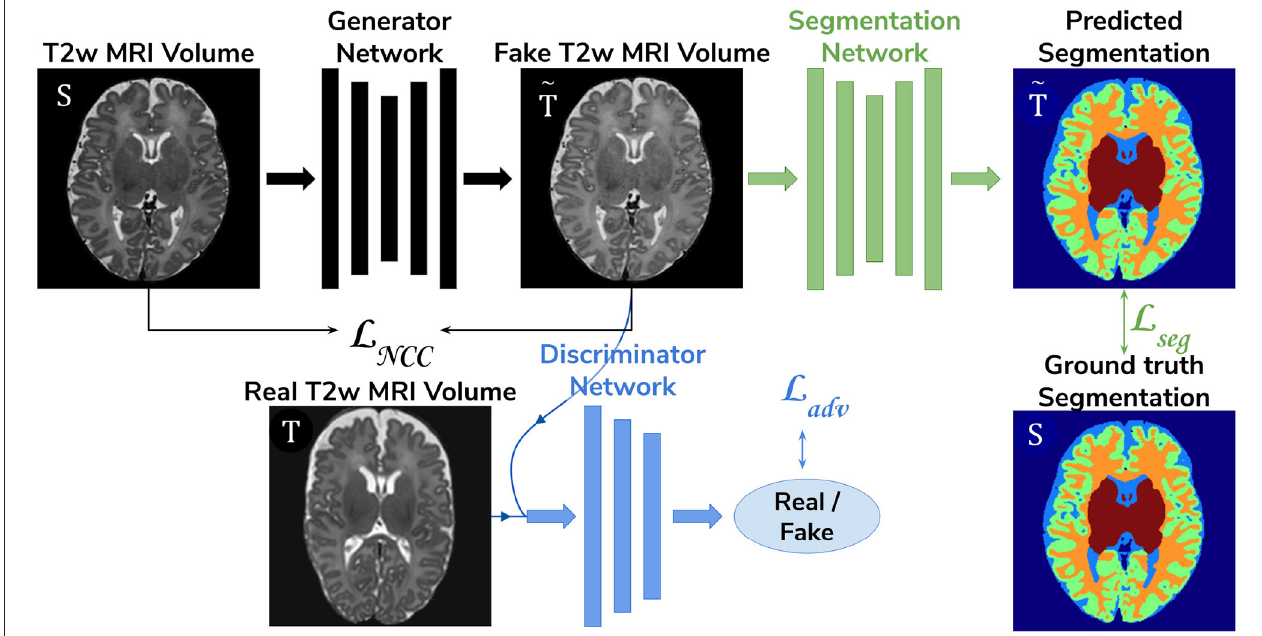
FIGURE 4 | The image space domain adaptation setup uses a generator network to produce ePrime-like T 2 w MRI images (marked with e T), which are then used as input into the segmentation network. The discriminator is trained to distinguish between real (ePrime) and synthesized (ePrime-like) volumes, while the generator is trained to produce realistic images in order to fool the discriminator. The NCC loss enforces image similarity between real and synthesized